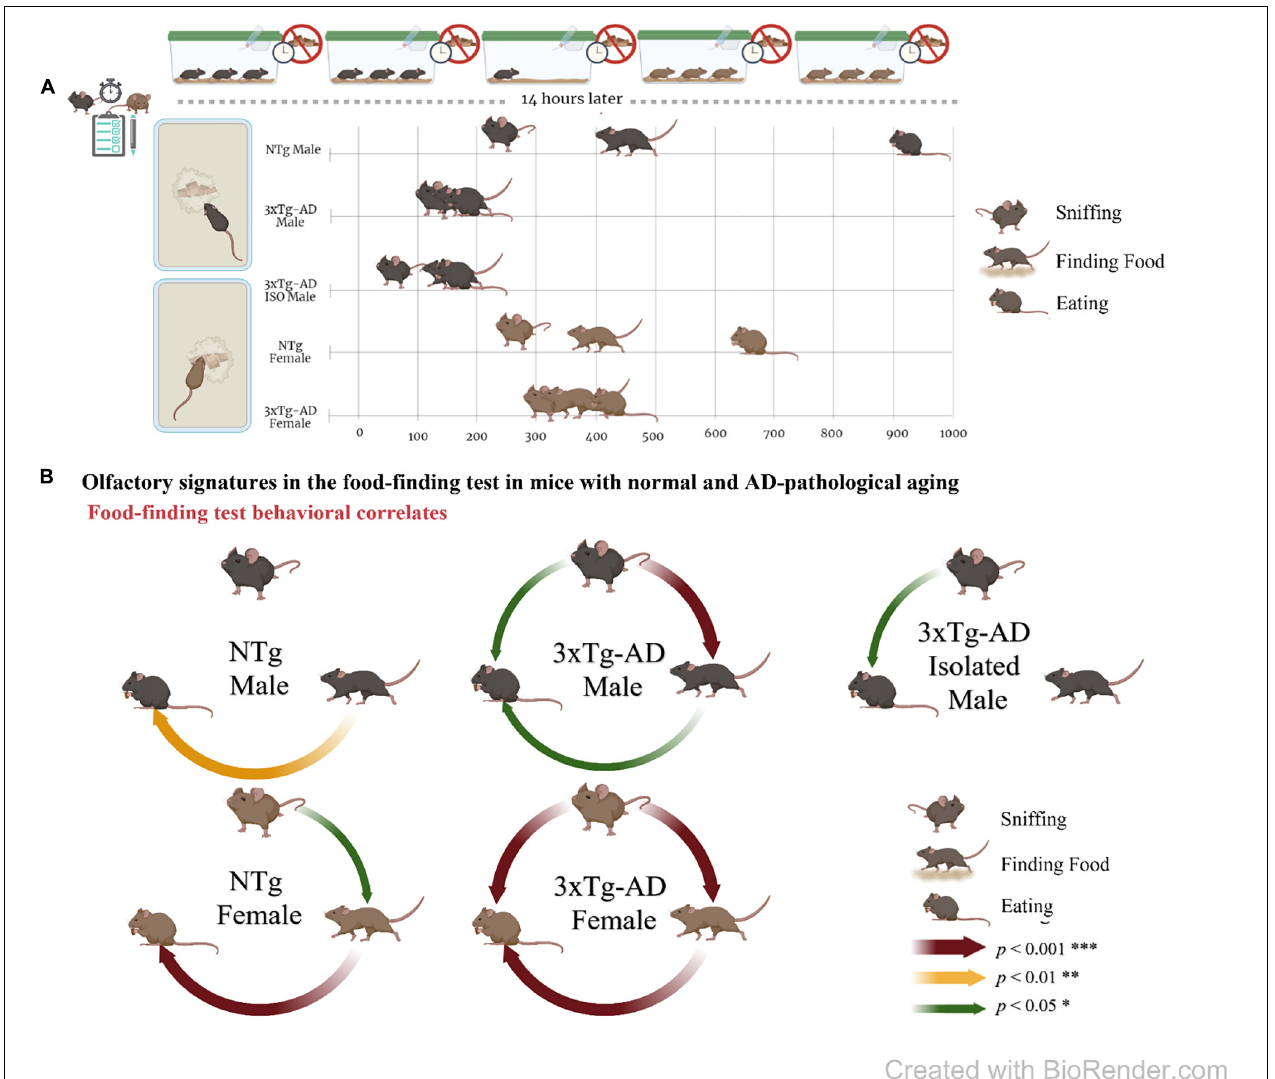
FIGURE 2 | Olfactory signatures in mice with normal and AD-pathological aging in the food finding test. (A) Experimental design and ethogram tablature for “sniffing, finding, and eating the hidden food pellet” by 13-month-old male and female 3xTg-AD and NTg mice and natural isolation male 3xTg-AD mice. (B) Meaningful correlation analysis in food finding test. Graphical representation of the significant Pearson r correlations between the three olfactory actions. All of them were positive. The figure was created with